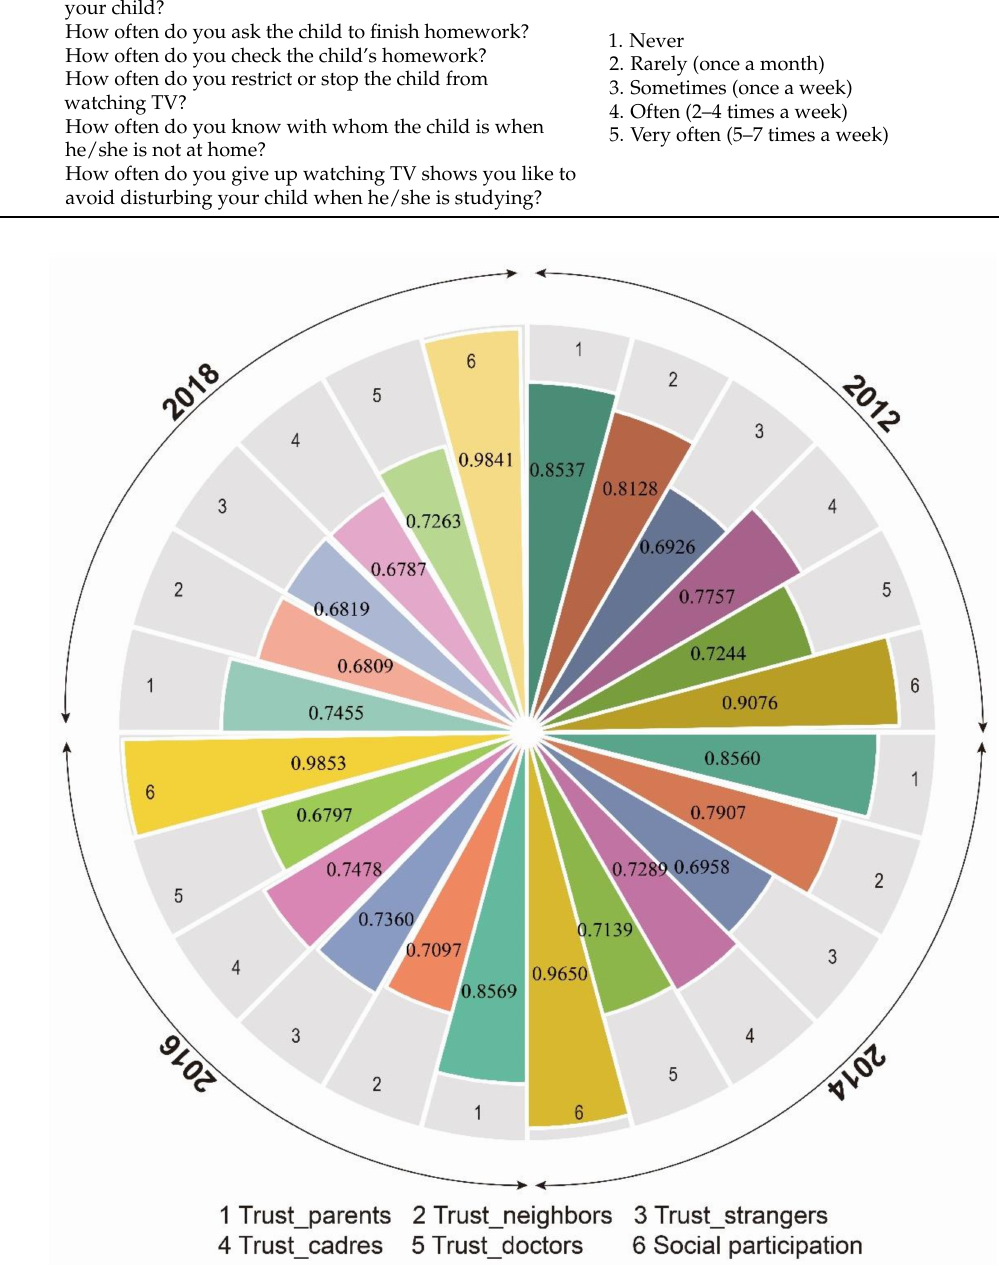
Figure 3. Within-group interrater reliability coefficients of the neighborhood social capital indicators (2012, 2014, 2016, and